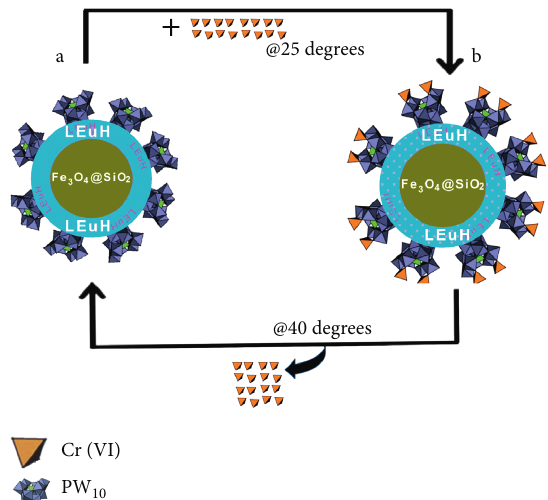
Figure 3: Proposed adsorption processes of Fe PW 10 adsorbent with hexavalent chromium